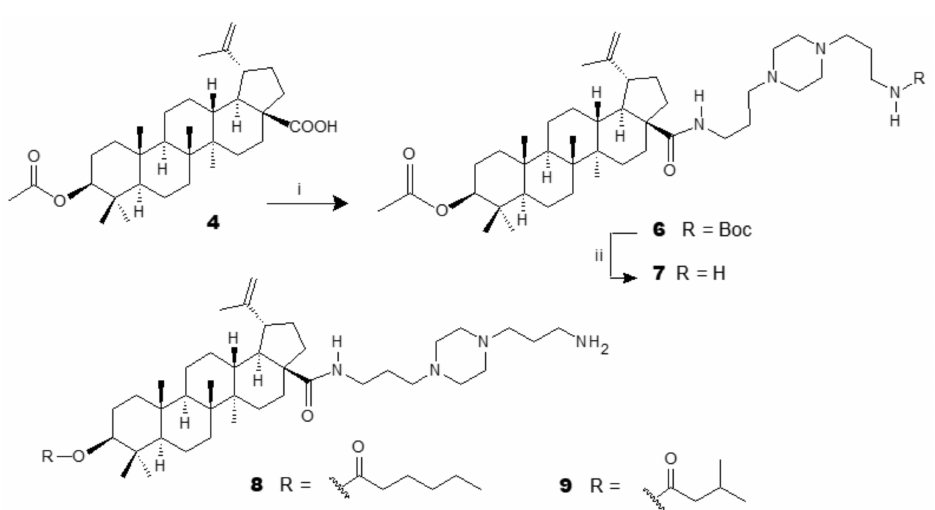
Figure 3. Simple antiplasmodial BA